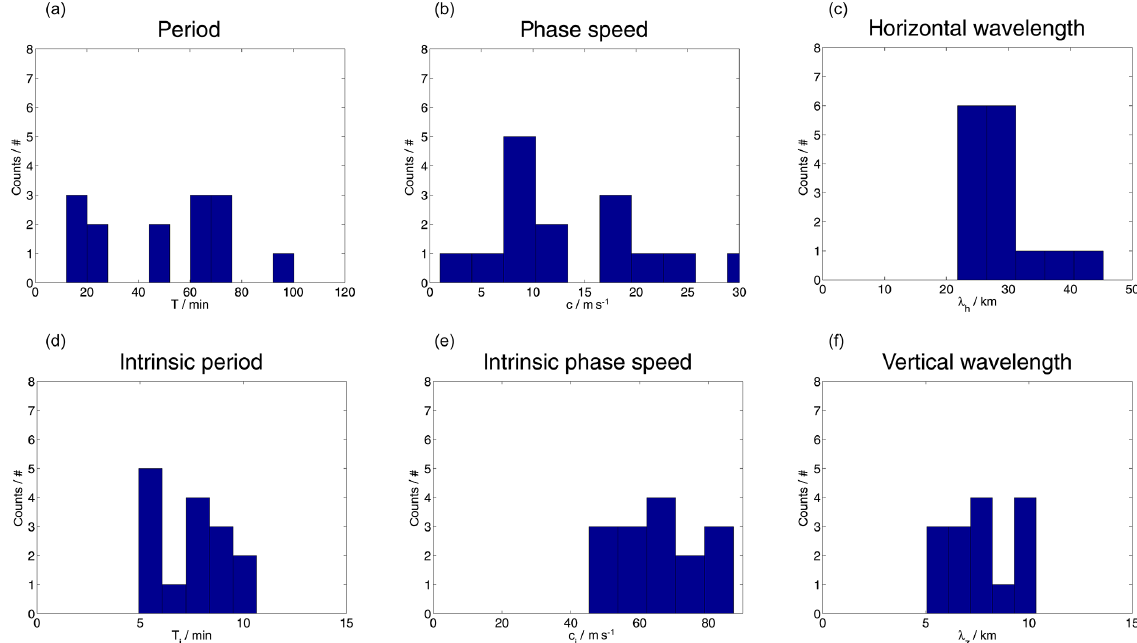
Figure 10. (a) Histogram of the observed GW periods. (b) Histogram of the determined phase speeds using the 2-D fit. (c) Obtained horizontal wavelengths. (d) Histogram of derived intrinsic GW periods. (e) Statistics of the computed intrinsic phase speeds. (f) Histogram of estimated vertical wavelengths assuming linear